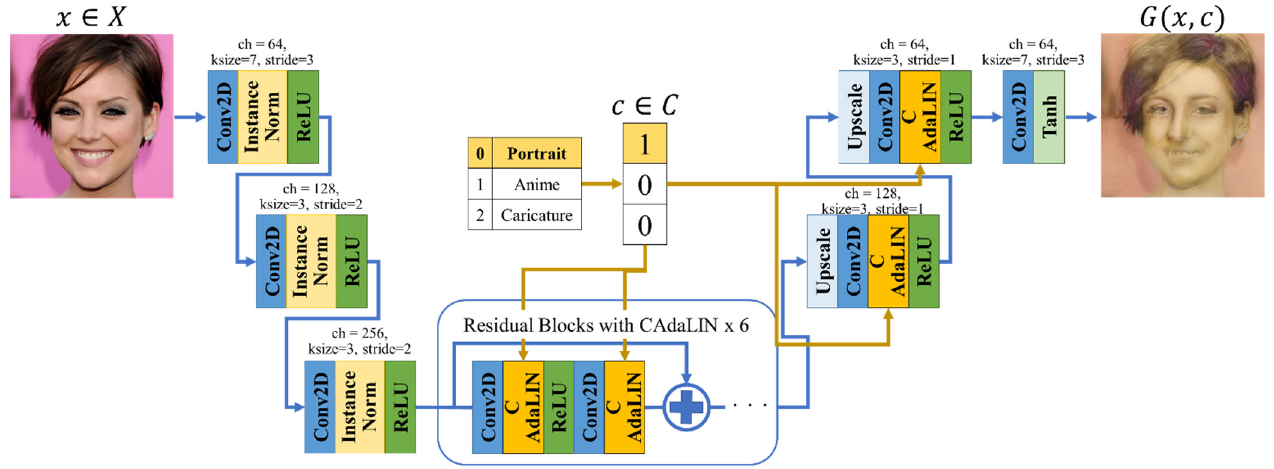
Figure 1. Overview of the generator in the Multi-CartoonGAN model.